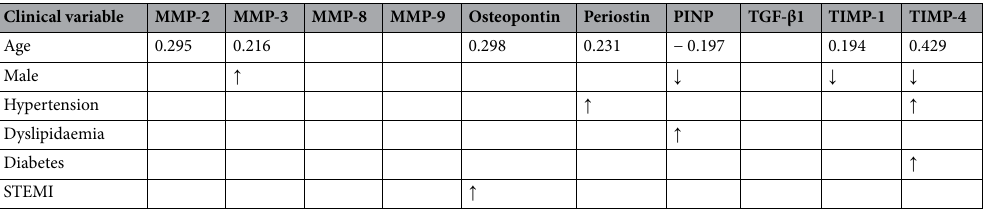
Table 2. Summary of significant relationships between ECM biomarkers and clinical characteristics. Only significant ( p < 0.05) relationships are shown in this table. For values and levels of significance, refer to Supplementary Tables S1 to S5 online. Spearman’s Rank correlation was conducted between age and ECM biomarkers. The strength of significant correlations has been recorded. Mann–Whitney U testing was used to identify differences between categorical variables and ECM biomarkers. An arrow indicates a significant relationship, with the direction specifying if ECM biomarker levels were increased ( ↑ ) or decreased ( ↓ ) for the clinical variable measured.